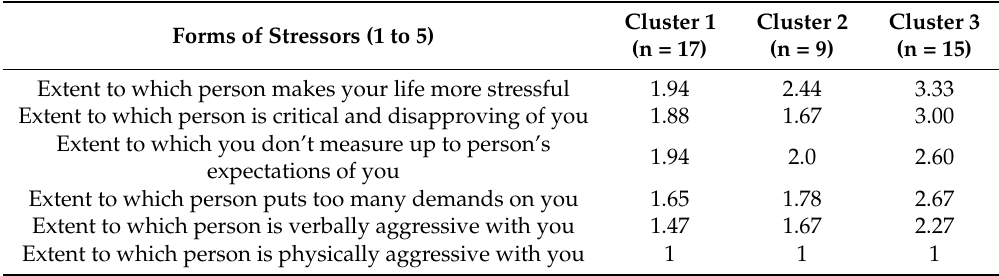
Table 3. Mean Level of Relationship stress by clusters of social support